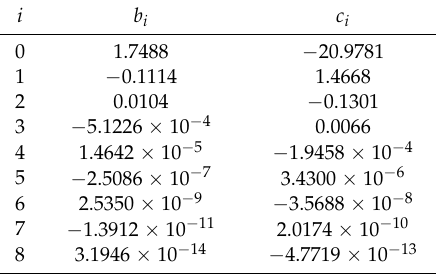
Table 2. The coefficients of polynomials for Equations (5) and